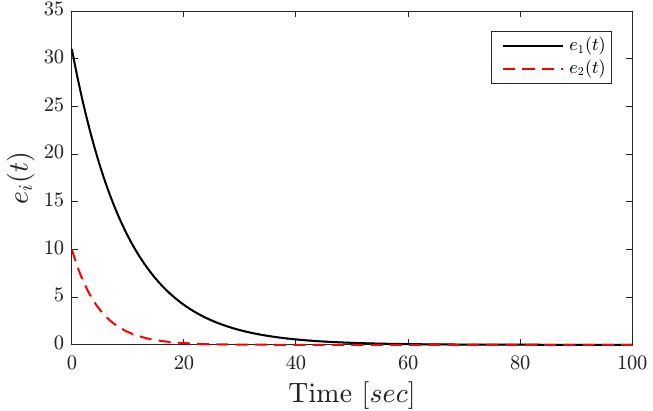
Figure 5. Time evolution of the synchronization error for the 2D